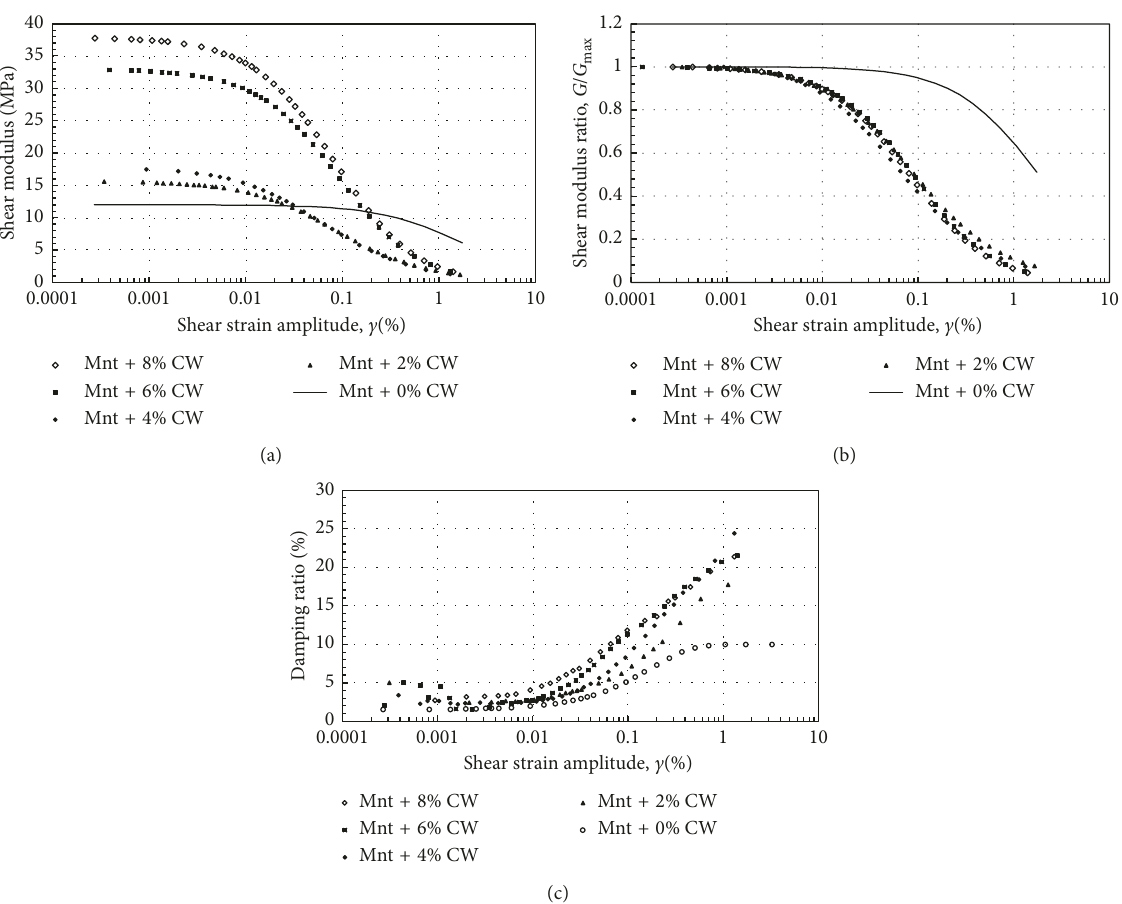
Figure 8: Comparison of (a) initial shear modulus, (b) shear modulus ratio, and (c) damping ratio of Mnt+CW